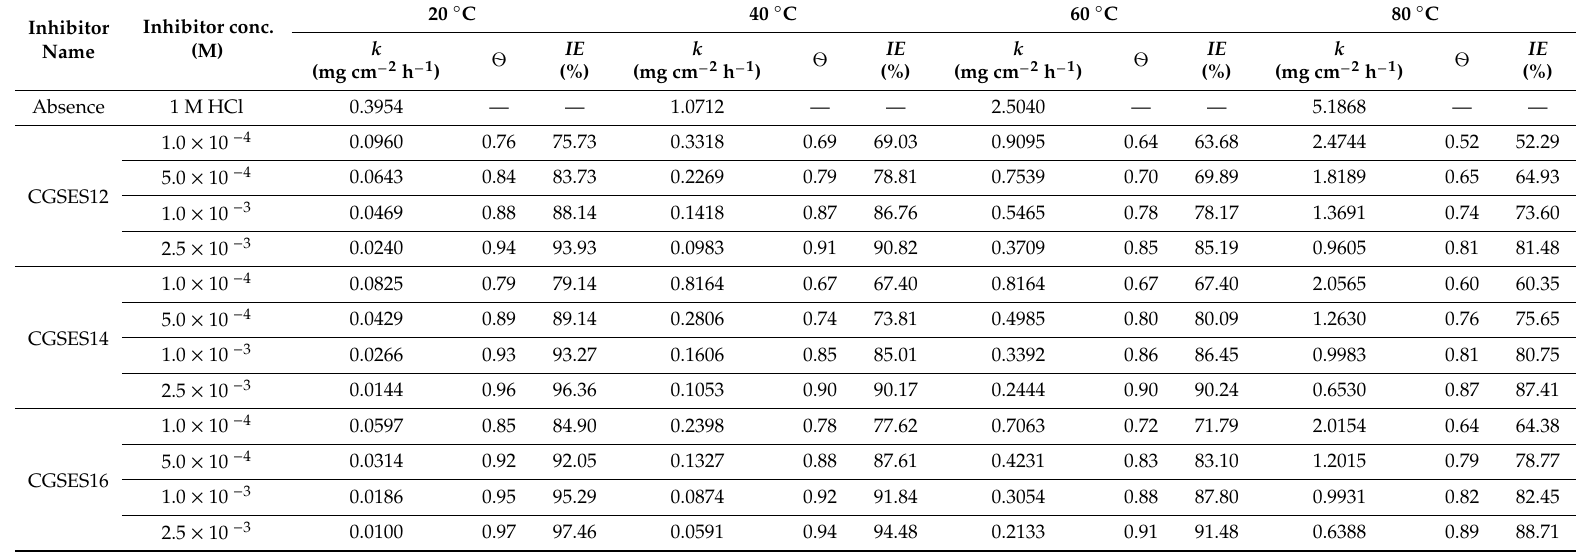
Table 6. Weight loss results for MS in 1 M HCl in the absence and presence of di ff erent concentrations of the synthesized cationic gemini surfactants at various